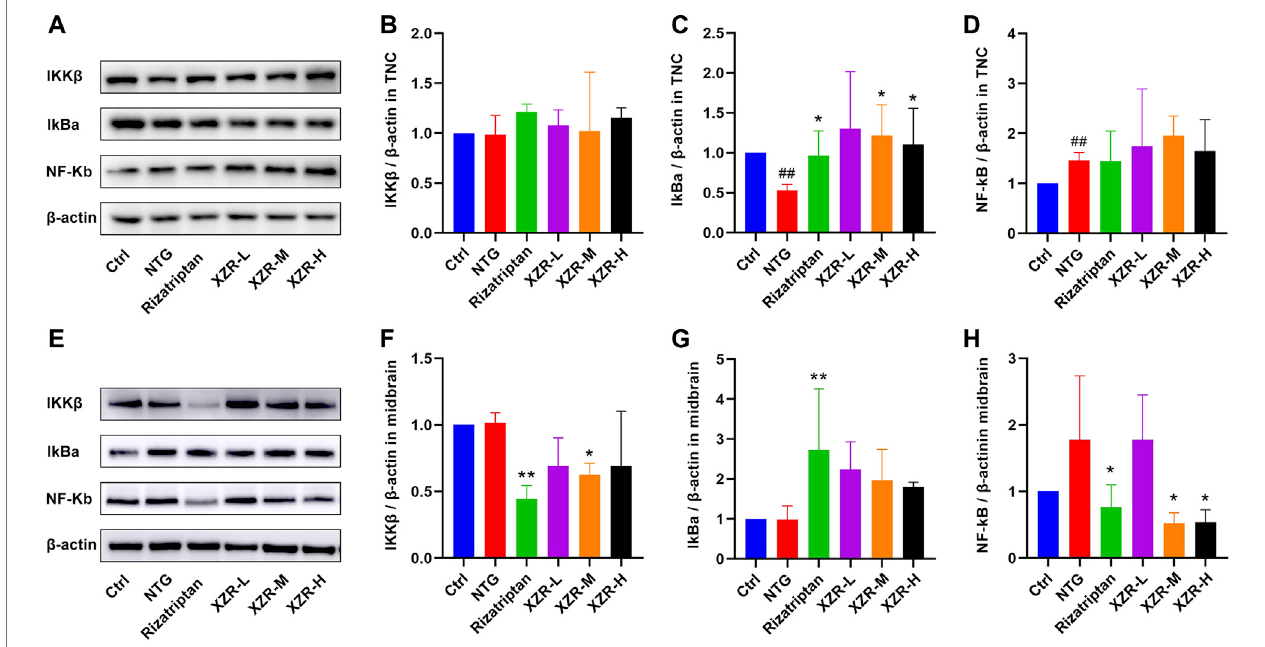
FIGURE7| XZRinhibited in fl ammation via the NF- κ B signaling pathway. (A) RepresentativeWesternblotimages ofIKK β , I κ B α , and NF- κ Bexpression inthe TNC. (B) Relative expression of IKK β in the TNC. (C) Relative expression of I κ B α in the TNC. (D) Relative expression of NF- κ B in the TNC. (E) Representative Western blot images of IKK β , I κ B α , and NF- κ B expression in the midbrain. (F) Relative expression of IKK β in the midbrain. (G) Relative expression of I κ B α in the midbrain. (H) Relative expression of NF- κ B in the midbrain. Data are presented as the mean ± standard deviation, n = 3 – 5. ## p < 0.01 versus the control group, * p < 0.05, ** p